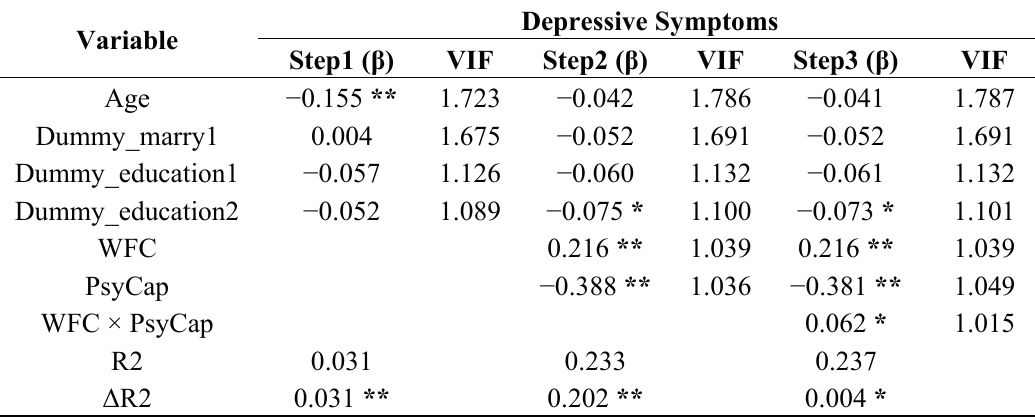
Table 4. WFC as the independent variable and PsyCap as the moderator in the regression analysis. Variable